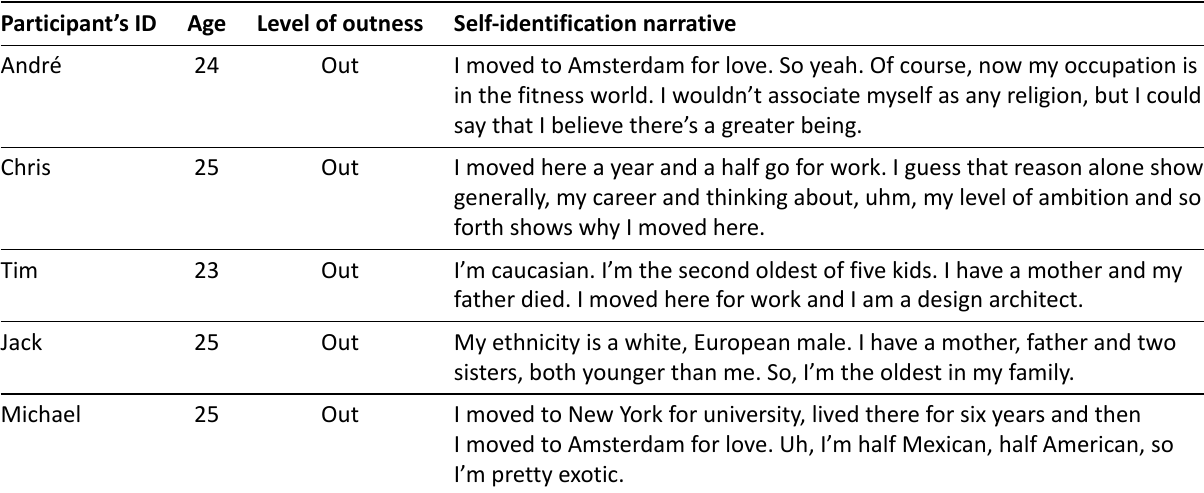
Table 2. Voluntary migrant demographics and their personal self-identification narratives. Participant’s